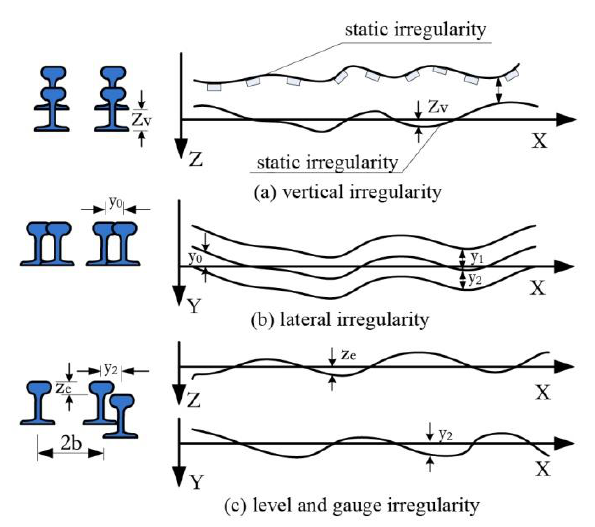
Figure 4. Schematic diagram of track irregularity.